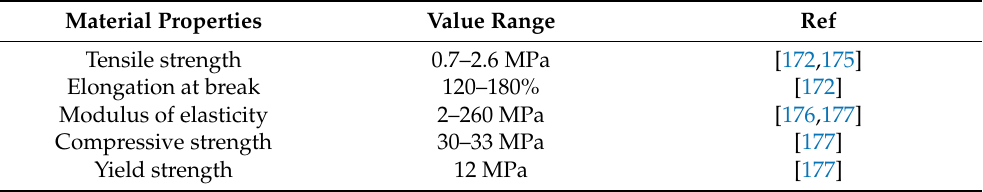
Table 9. Physical and mechanical properties of PLGA and its composite material.